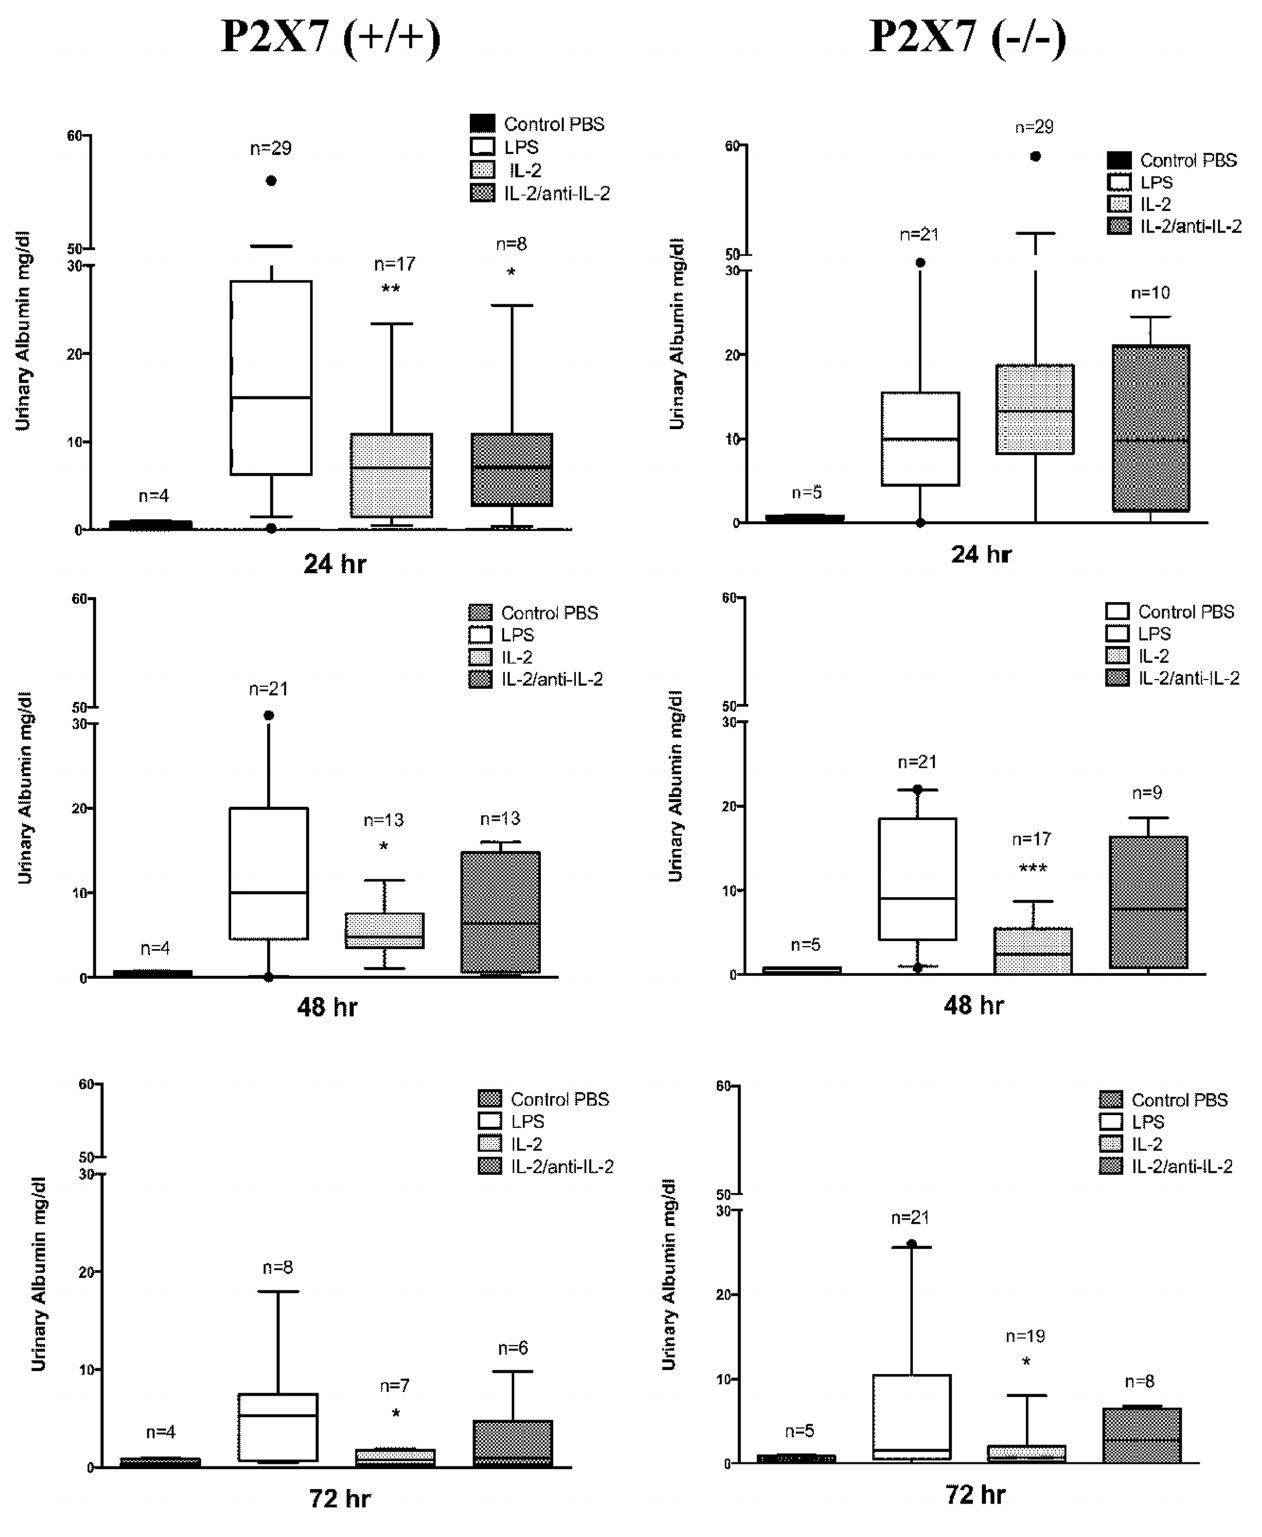
Figure 1. Proteinuria outcome in LPS mice. Urinary albumin levels were evaluated with immune-western after LPS (12 mg/Kg) treatment (24 hrs, 48 hrs and 72 hrs after treatment) in wild C57BL/6 and in P2 6 7 2 / 2 mice. In some cases and in both experimental groups (WT and P2 6 7 2 / 2 ) IL-2 (18.000 U) and/or IL-2/anti-IL-2 were infused prior LPS to regulate circulating and tissue Tregs (see Figure 3). *=p # 0.05, **=p # 0.005, ***=p # 0.0005.